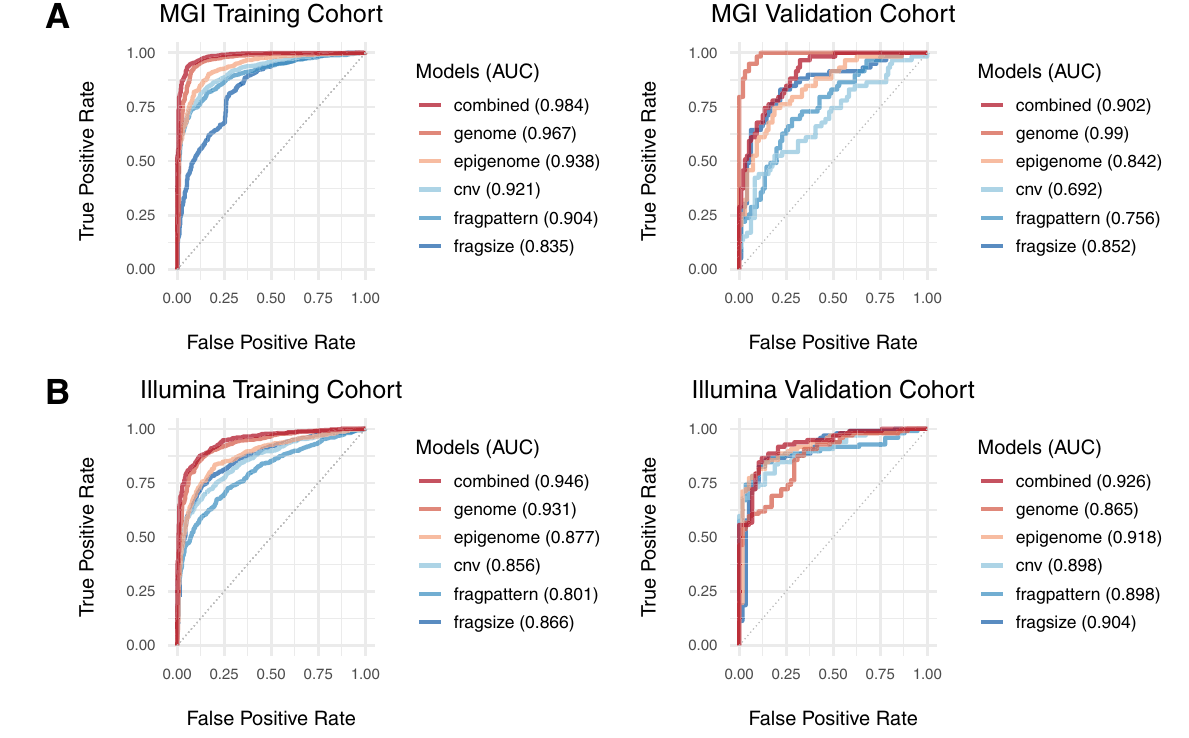
con fi dence interval at 95% speci fi city broken down by the tumor stage (left) and cancer type (right) for the C MGI training cohort and D Illumina training cohort. Con fi dence interval for sensitivity value was calculated from 1000 bootstraping samplings. A – D Our genome, epigenome, and combined models were compared with predictions based on fragmentation patterns 9 (fragpattern), fragment size pro fi les 8 (fragsize), and copy number variations 3 (cnv). NA Stage information not available, CI Con fi dence interval. Source data are provided as a Source Data fi